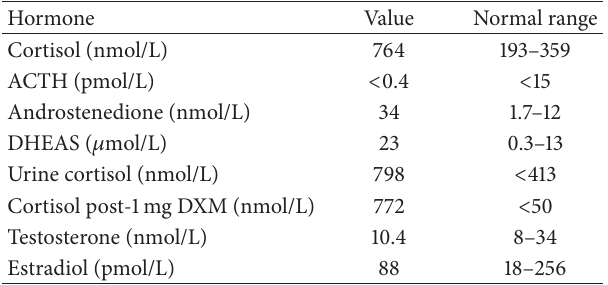
Table 1: Hormone measurements in plasma before surgery.